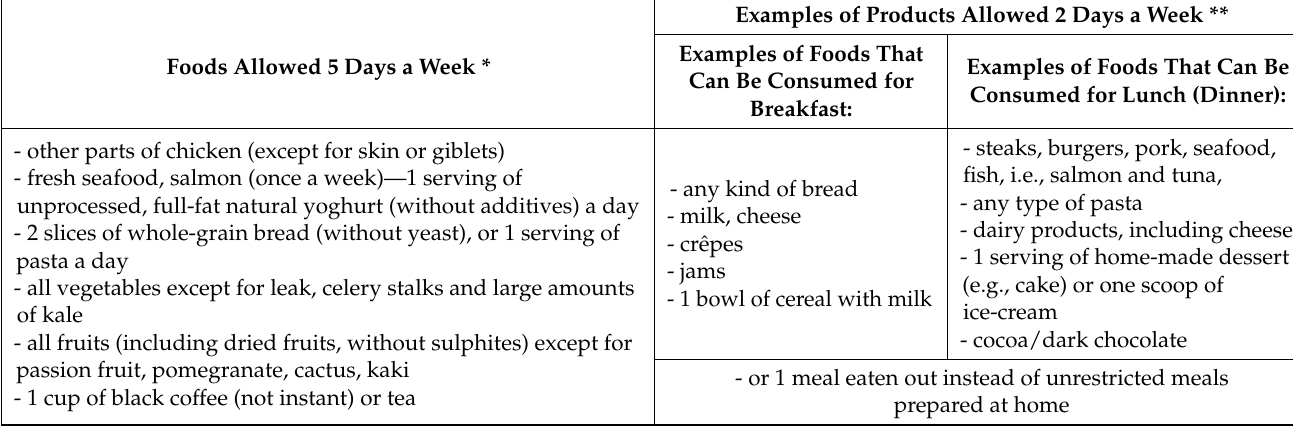
Table 3. Foods allowed in the maintenance phase of